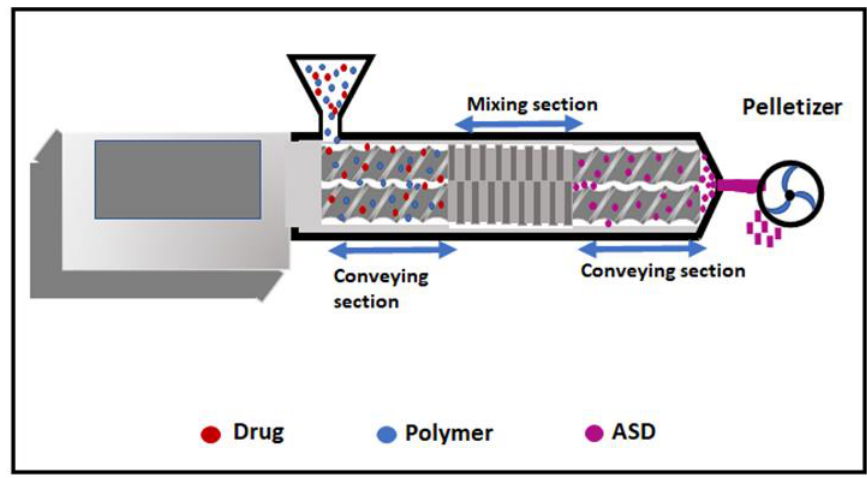
Figure 1. Schematic presentation of ASD preparation through HME